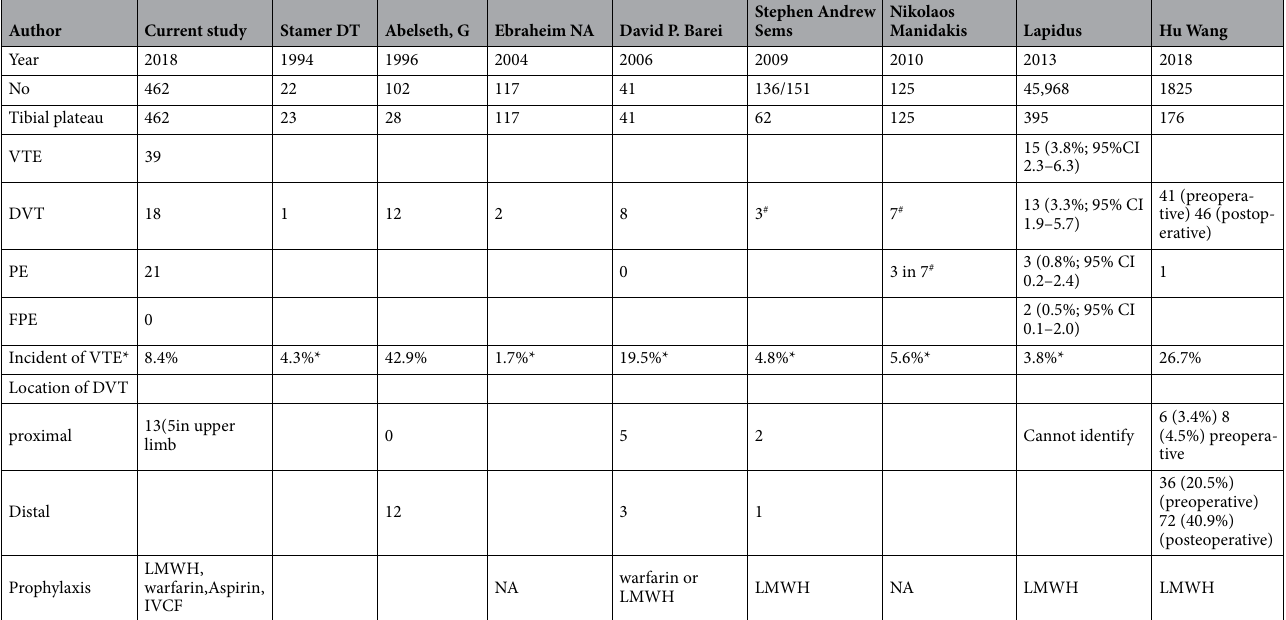
Table 5. Comparison of the current study with previous studies on VTE in tibia plateau fractures. The comparisons were informality. # The number of DVT or PE were not the accurate. *The incidences of VTE were not provided by authors. These incidences were calculated by us according the data from original